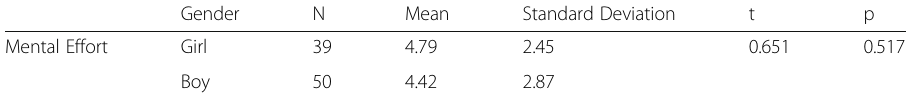
Table 2 T test results for effect of gender to mental